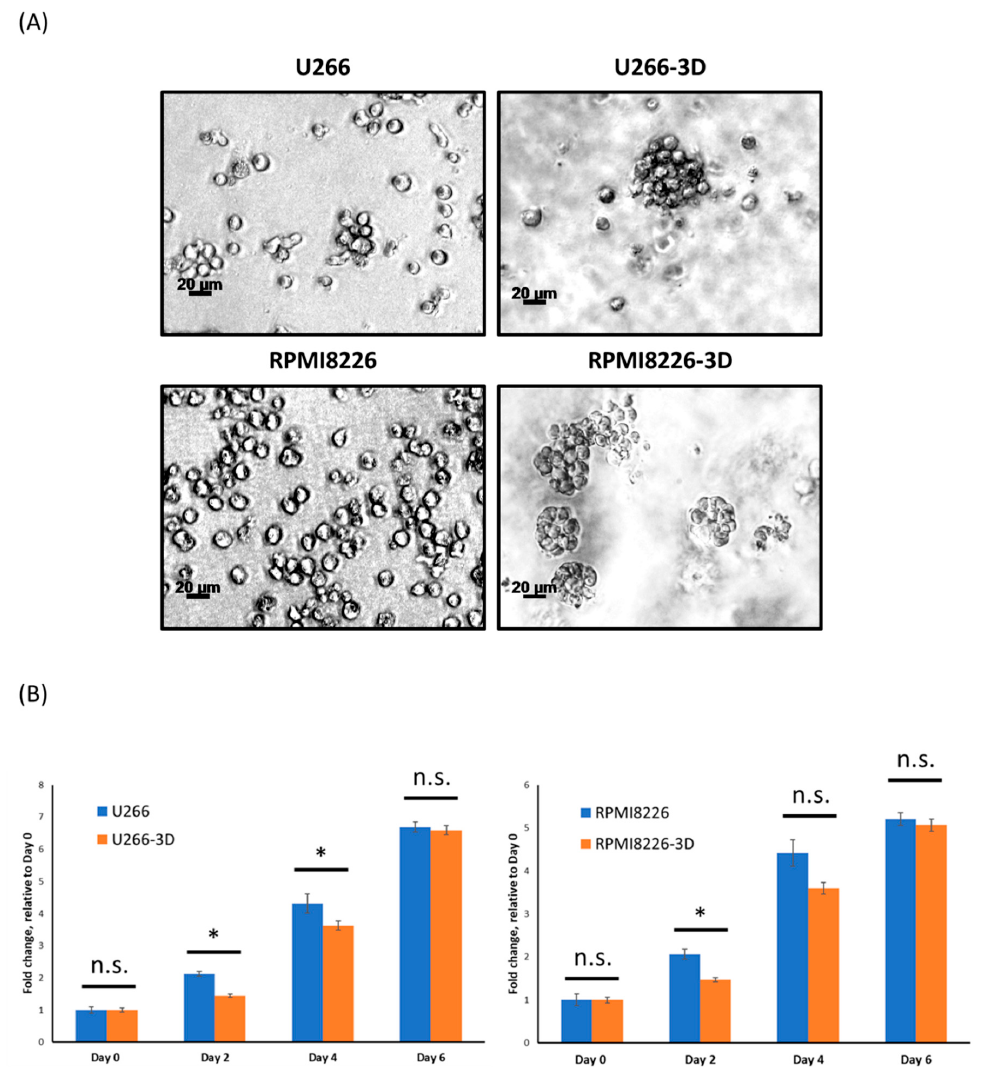
Figure 1. MM cells exhibit different appearances and growth patterns in conventional culture versus in 3D culture. ( A ) The morphology of U266 and RPMI8226 cells in conventional or 3D culture after 6 days was examined by phase contrast microscopy. Images were taken at 100X magnification. A scale bar equivalent to 20 µm is included in each graph; ( B ) The growth of U266 and RPMI8226 cells in conventional (blue bars) or 3D cultures (orange bars) was measured by the trypan blue exclusion assay at various time points. Fold changes of total viable cells were normalized to the cell number on day 0 (2.5 × 10 5 cells). The error bars represent standard deviation from a triplicate experiment, * p < 0.05, n.s. not significant, Student’s t -test.